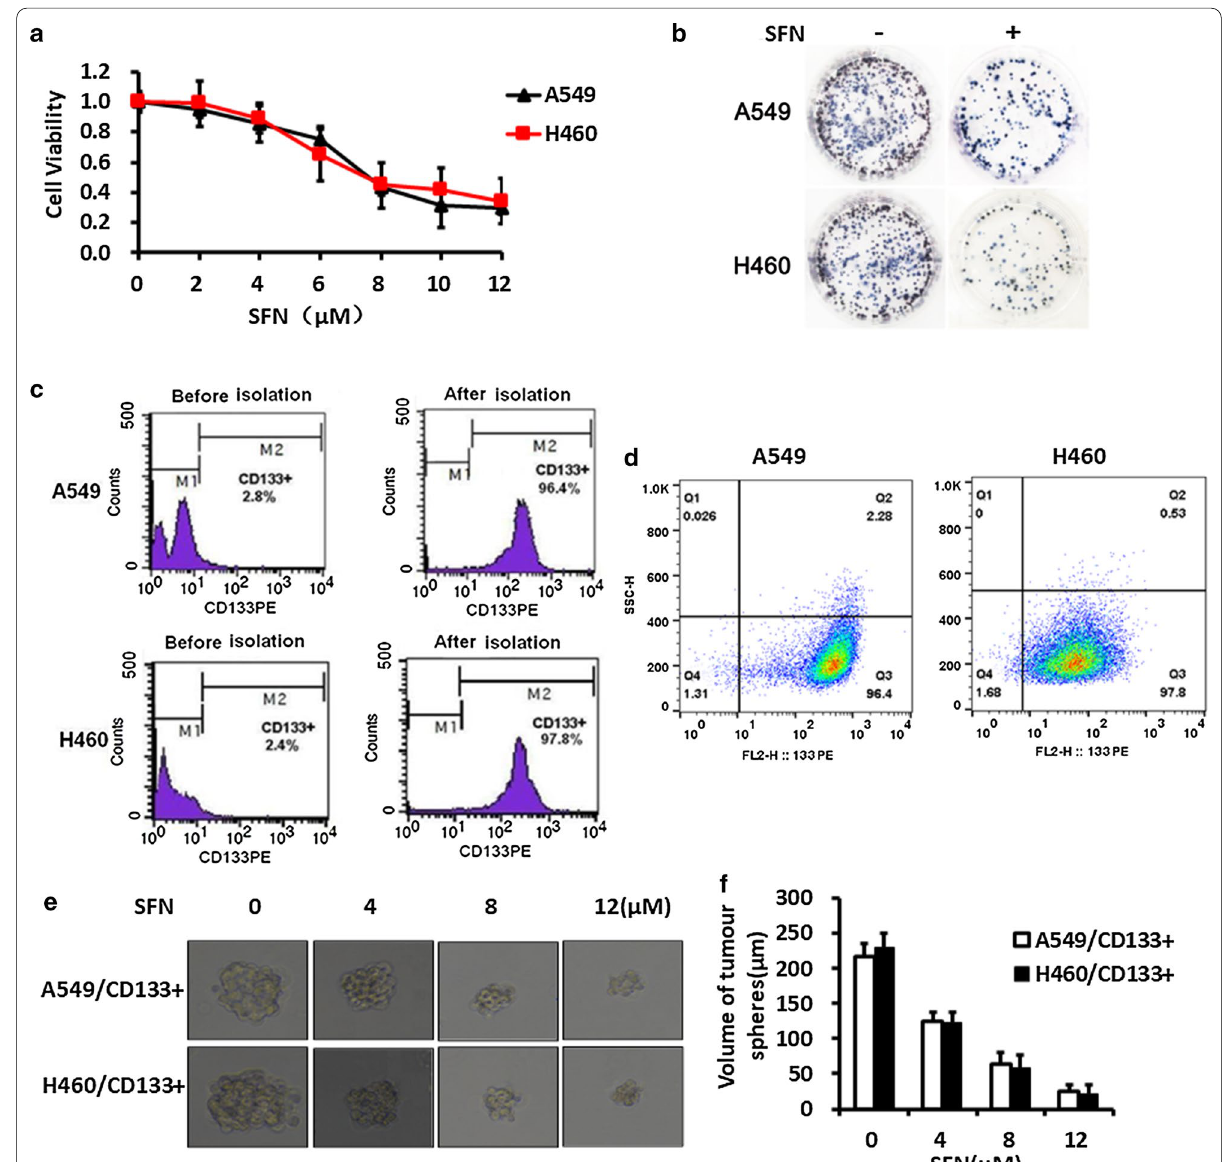
Fig. 1 Inhibitory effect of SFN on cell proliferation. a Inhibitory effect of SFN on viability of A549 and H460 cells in a dose-dependent manner following treatments with 0, 2, 4, 6, 8, 10 and 12 μmol/L SFN for 48 h by MTT assay. b Inhibitory effect of SFN on cell density of A549 and H460 cells following treatments with 8 μmol/L SFN for 48 h by optical microscope. c , d CD133 + cells were isolated from human lung cancer A549 and H460 cells by Macs. Before sorting, the positive rate of CD133 are 2.8% and 2.4%. And after sorting, the positive rate of CD133 are 96.4% and 97.8% in A549 cells and H460 cells, respectively. e , f The tumor sphere volume of A549/CD133 + and H460/CD133 + cells were inhibited by SFN in a dose-dependent